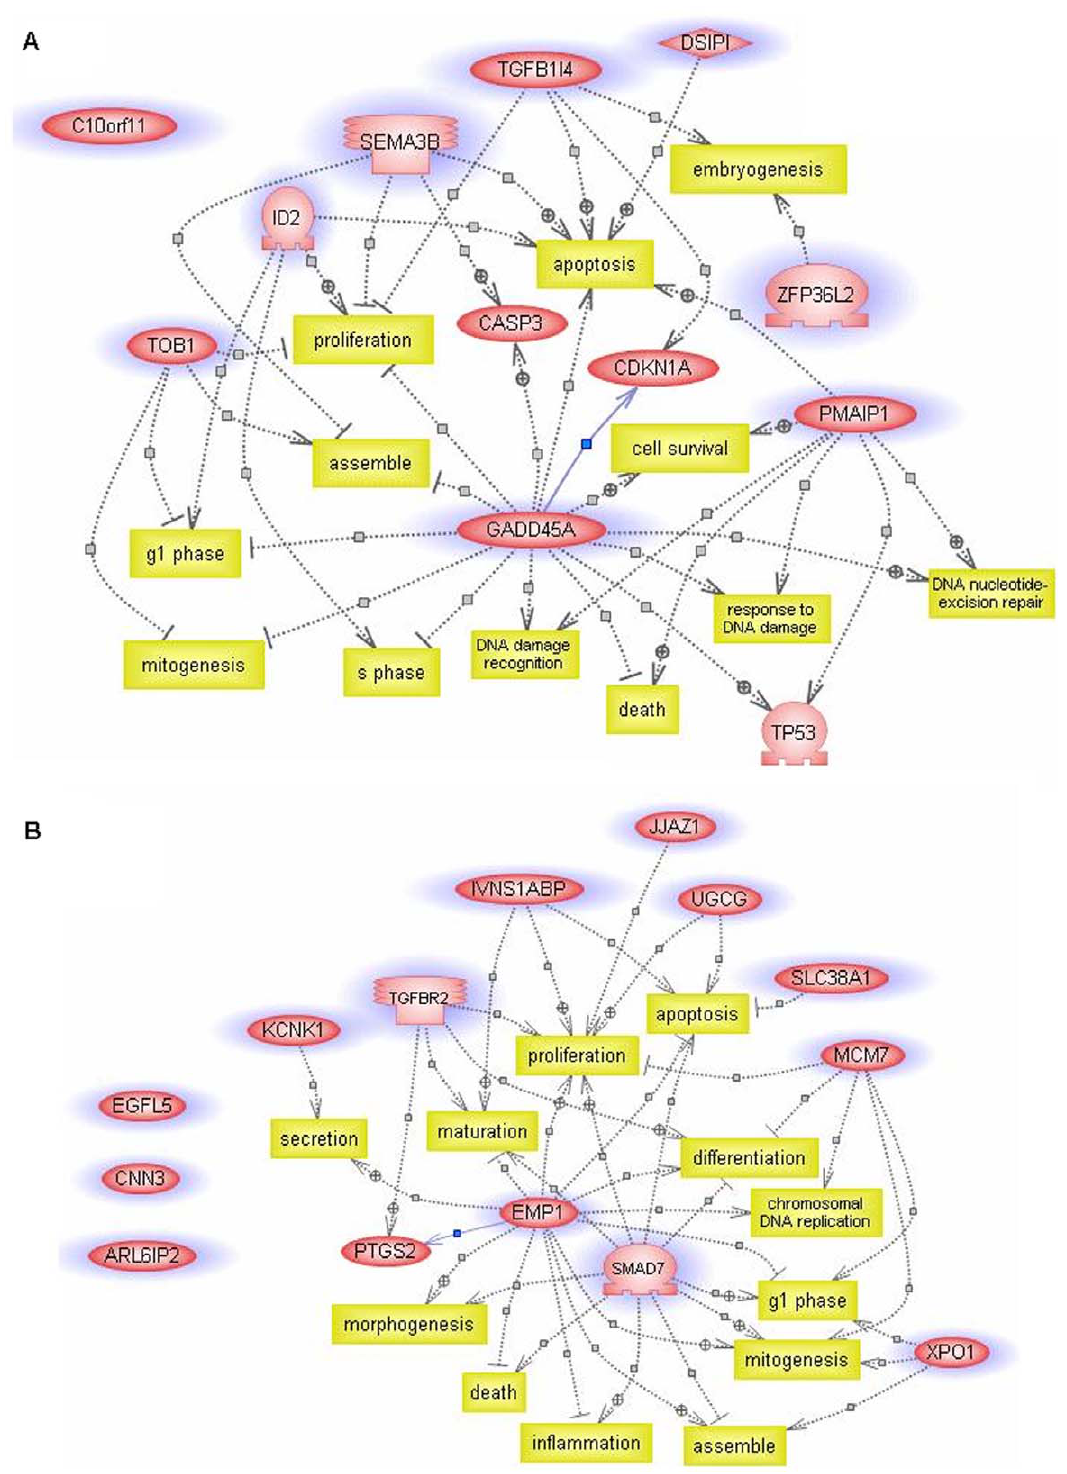
Figure 3. Pathway analysis of genes with steady-state response to repeated small UVB perturbations created using PathwayAssist. A ) Up-regulated genes are primarily associated with the functions of anti-proliferation, anti-mitogenesis, and apoptosis. B ) Down-regulated genes are mainly related to the functions of proliferation, mitogenesis, and anti-apoptosis. The plus and the minus symbols mark positive and negative regulations, respectively. Yellow boxes mark biological functions. Purple circles mark genes teased out by the steady-state model-fitting algorithm. Genes without data connection in the PathwayAssist database are pictured on the left without connection.